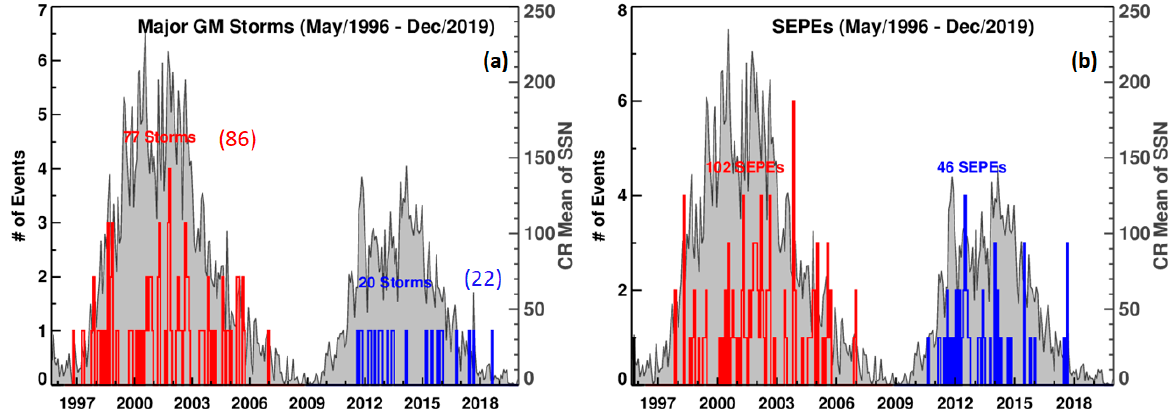
Figure 23. # means Number. The number of CME-associated major geomagnetic storms ( a ) and large SEP events (SEPEs) ( b ) summed over Carrington rotation periods. In ( a ), the numbers in parentheses are the total number of storms including those due to CIRs. SSN is shown in gray.